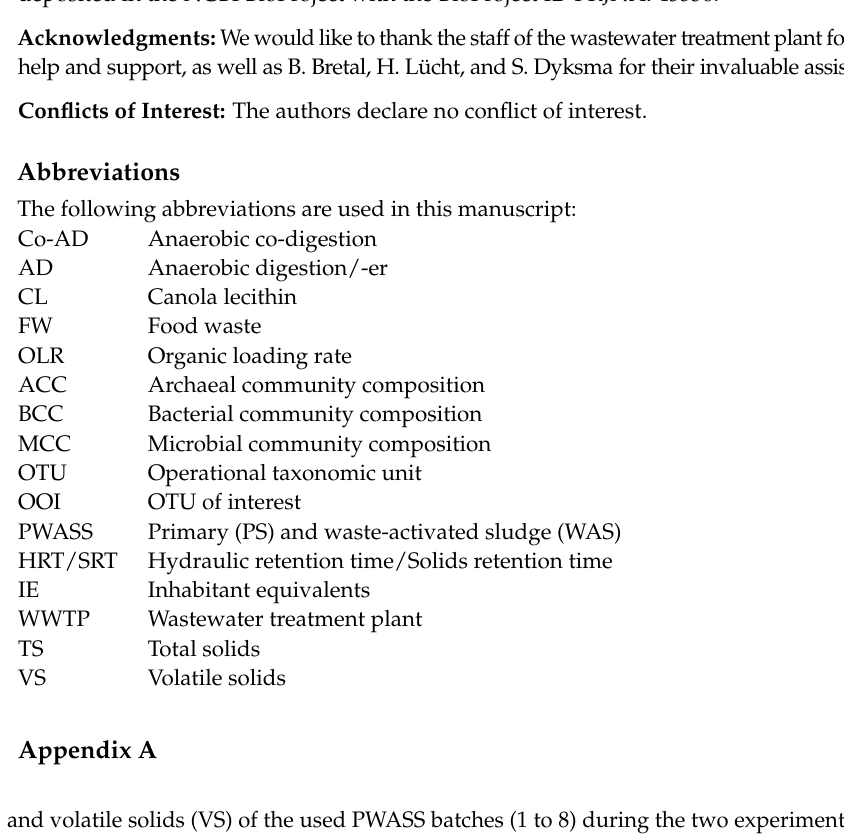
Table A1. Total solids (TS) and volatile solids (VS) of the used PWASS batches (1 to 8) during the two experiments (FW, CL) with the resulting organic loading rates of the daily feeding (OLR), with or without the respective co-substrate addition. PWASS